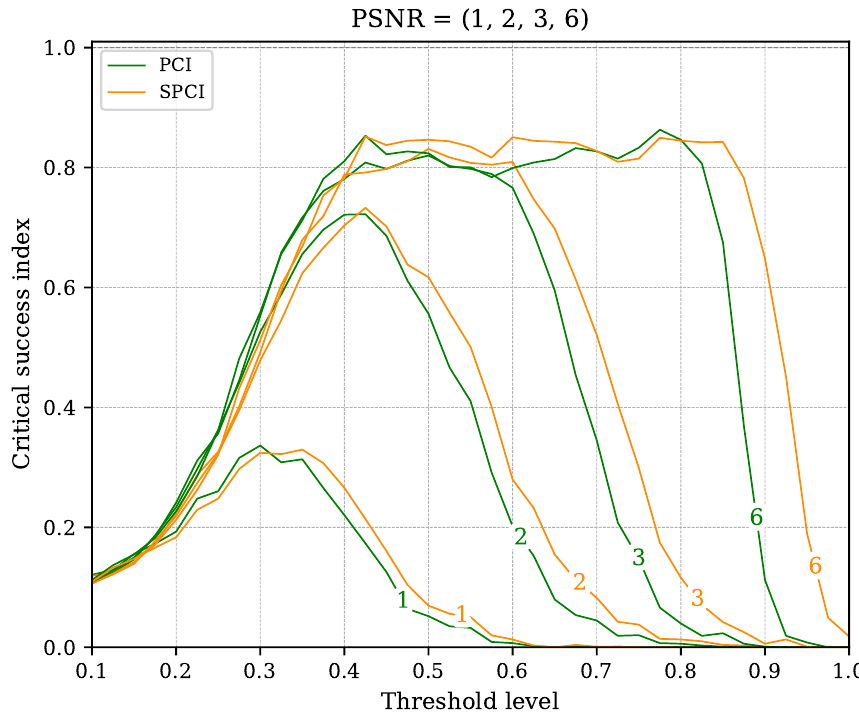
Figure 11. Critical Success Index estimation of both algorithms (PCI and SPCI) versus threshold level. A family of curves represents the different PSNR values evaluated along the threshold